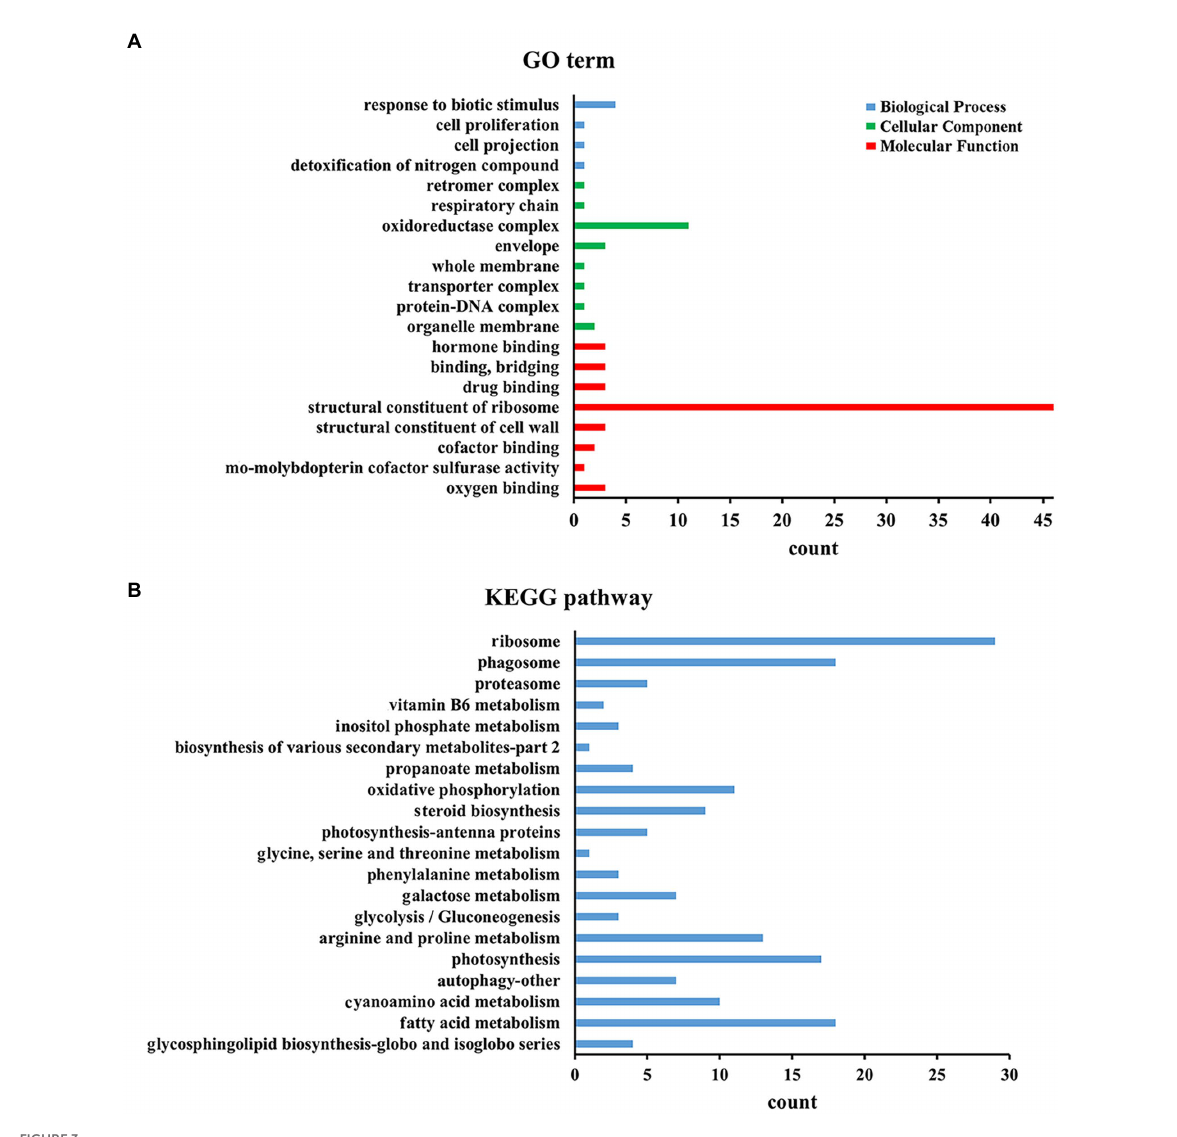
FIGURE 3 Top KEGG and GO enrichment analyses of all the DEGs. (A) Top 20 KEGG enrichment of all the DEGs. (B) Top 20 GO enrichment of all the